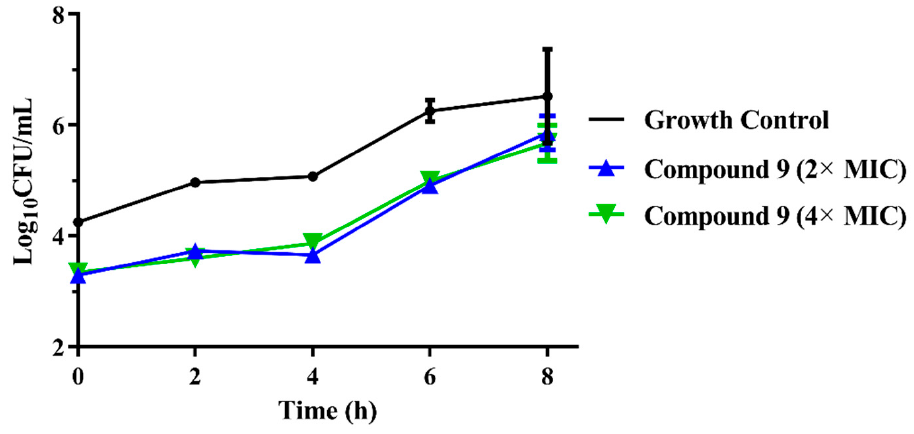
Figure 3. The bacterial growth kinetic curves for MRSA ATCC 43300 exposed to compound 9 with concentrations of 2 × MIC and 4 × MIC for 2 h.